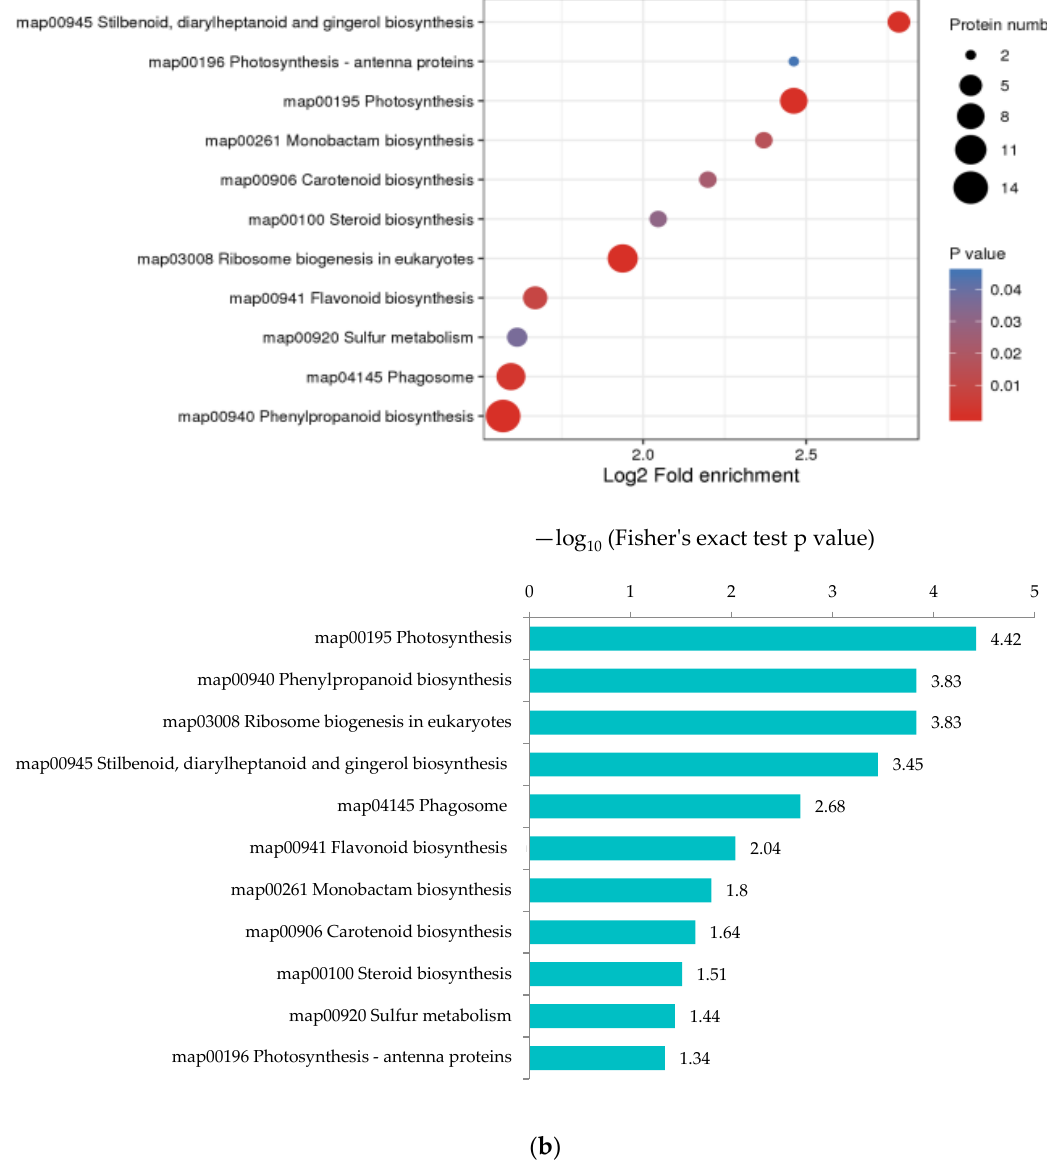
Figure 6. KEGG enrichment analysis of DEPs in R3/R1. In the bubble diagram, the redder the color, the more significant the enrichment of categories. ( a ) KEGG enrichment analysis of up-regulated DEPs in R3/R1. ( b ) KEGG enrichment analysis of down-regulated DEPs in R3/R1.